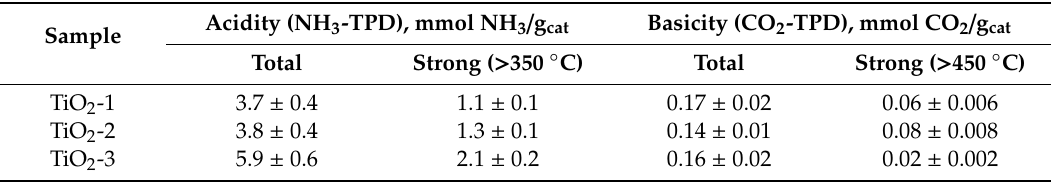
Table 2. The concentrations of acid and basic sites, shown as the total amount and the amount of strong sites, at the surface of TiO 2 solids used in the present study according to NH 3 - and CO 2 -TPD